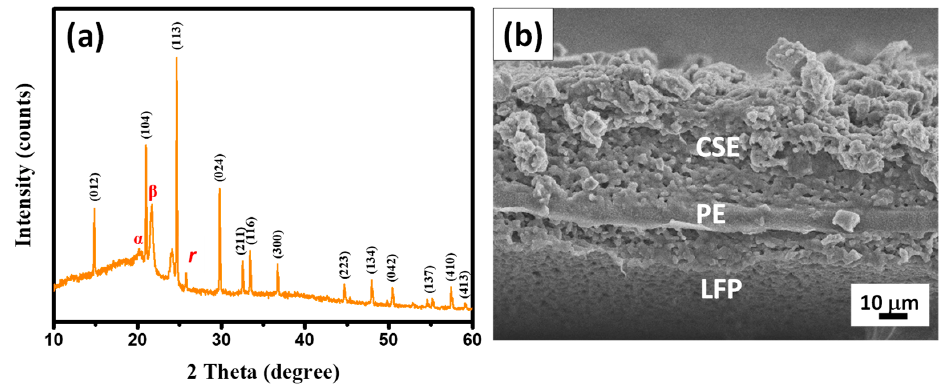
Figure 3. ( a ) Typical XRD pattern and ( b ) cross-sectional view of an FE-SEM image of a CSE-coated LFP cathode sheet.